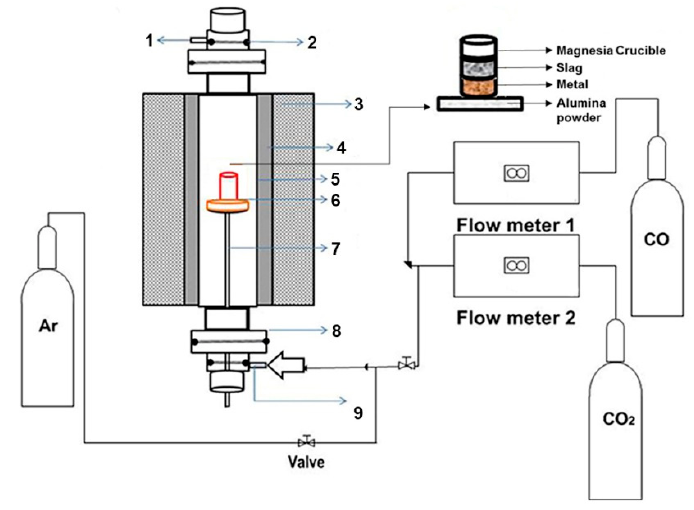
Figure 2. A schematic of experimental apparatus consisting of a vertical tube furnace, digital gas flow meters and different gases used in the current study. Legend: 1—gas outlet, 2—silicone O-ring, 3—MoSi 2 heating elements, 4—alumina tube, 5—mullite tube, 6—magnesia crucible, 7—alumina pedestal, 8—water-cooled flange, 9—gas inlet [22].